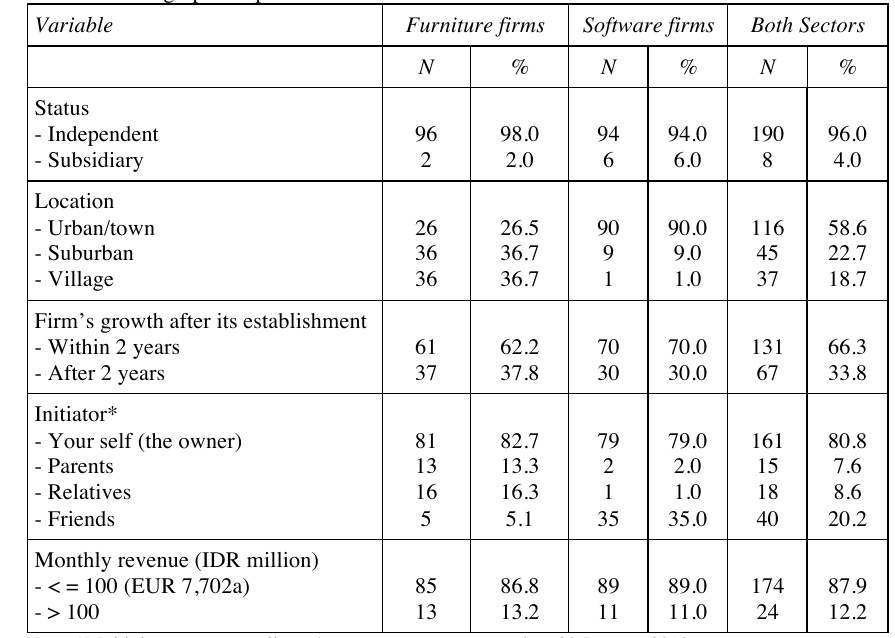
Table 2. Demographic aspects of